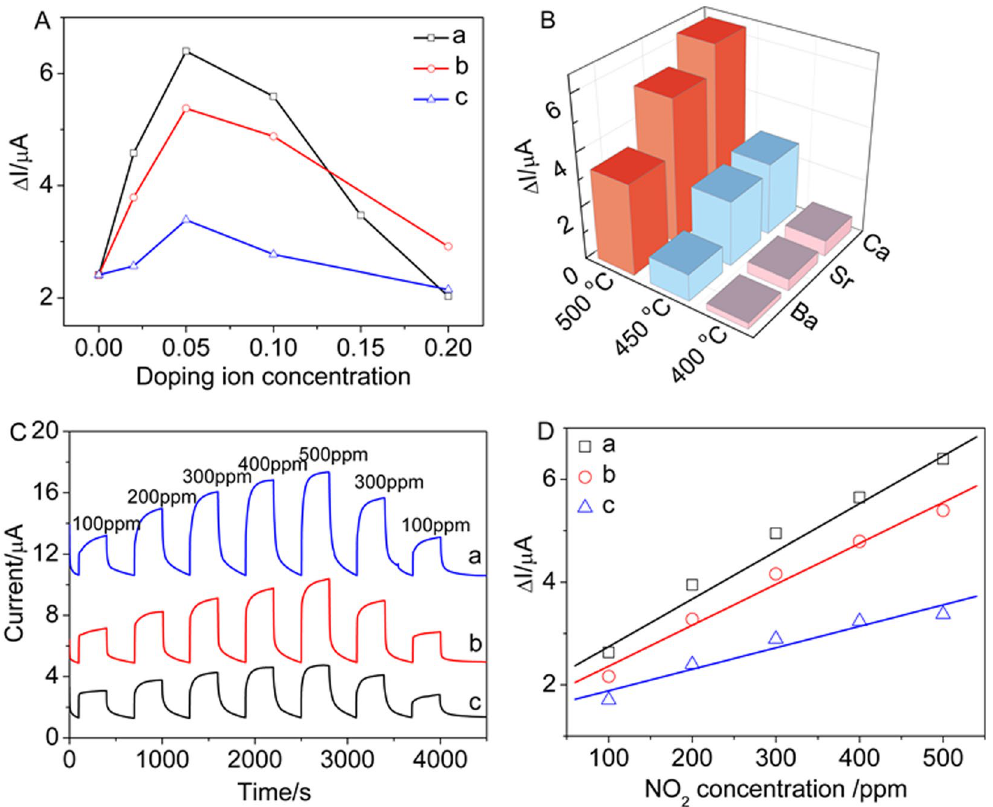
Figure 7. ( A ) The effect of doping concentration for different element on the Δ I value in 500 ppm NO 2 at 500 °C: (a) Gd 2 − x Ca x Zr 2 O 7 + δ , (b) Gd 2 − x Sr x Zr 2 O 7 + δ , (c) Gd 2 − x Ba x Zr 2 O 7 + δ ; ( B ) the effect of doping element and temperature on response signal Δ I in 500 ppm NO 2 at 500 °C; ( C ) Amperometric response and recovery transients to various NO 2 concentrations of the sensor in the presence of 5 vol. % O 2 at 500 °C (applied potential − 300 mV, flow rate 200 cm 3 /min): (a) Gd 1.95 Ca 0.05 Zr 2 O 7 +δ , (b) Gd 1.95 Sr 0.05 Zr 2 O 7 +δ , (c) Gd 1.95 Ba 0.05 Zr 2 O 7 +δ ; ( D ) the relationship between the response current values Δ I and NO 2 concentrations at 500 °C: (a) Gd 1.95 Ca 0.05 Zr 2 O 7 +δ , (b) Gd 1.95 Sr 0.05 Zr 2 O 7 +δ , (c) Gd 1.95 Ba 0.05 Zr 2 O 7 +δ